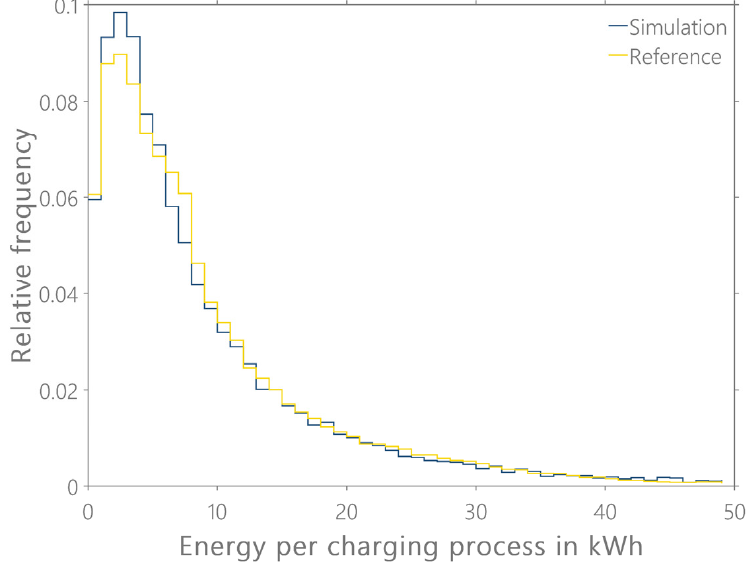
Figure 16. Relative frequency of energy consumption per charging process.